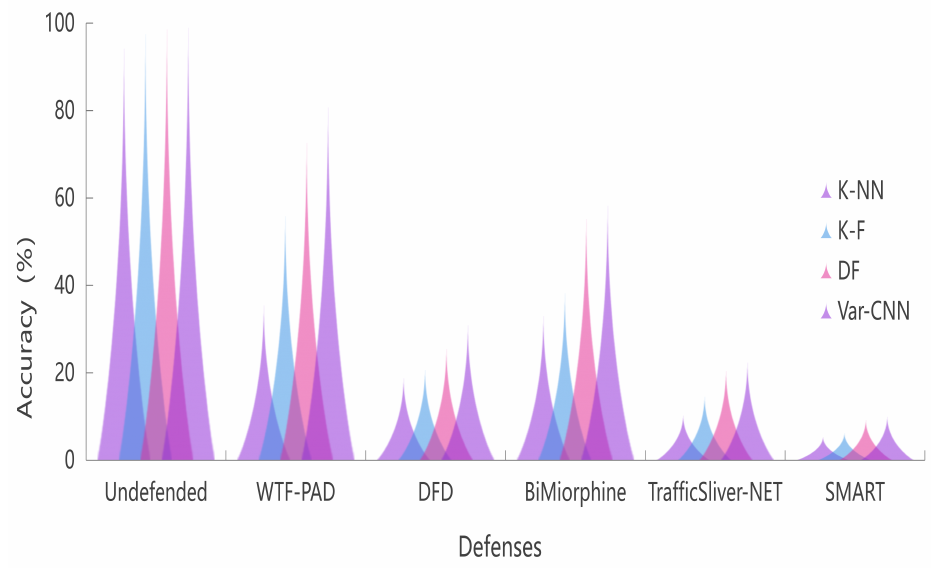
Figure 8. Comparison with the other four state-of-the-art